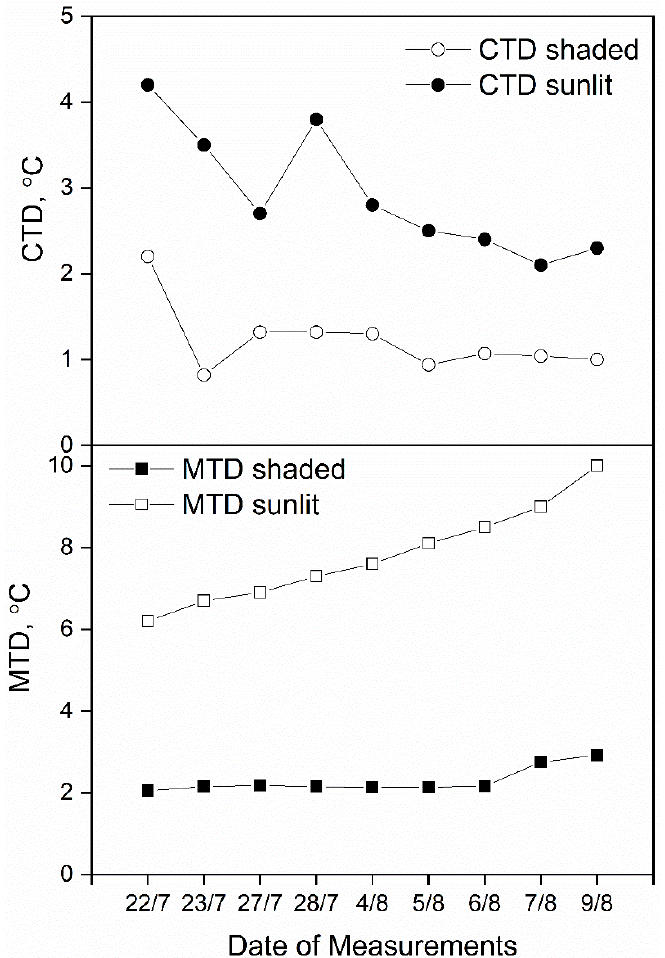
Figure 3. Maximum temperature difference (MTD) and canopy temperature difference (CTD) of sunlit and shaded leaves on different dates of measurements.